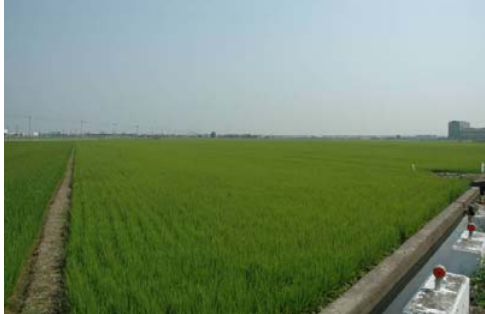
Figure 4. Planning should protect irrigated farms from unexpected changes